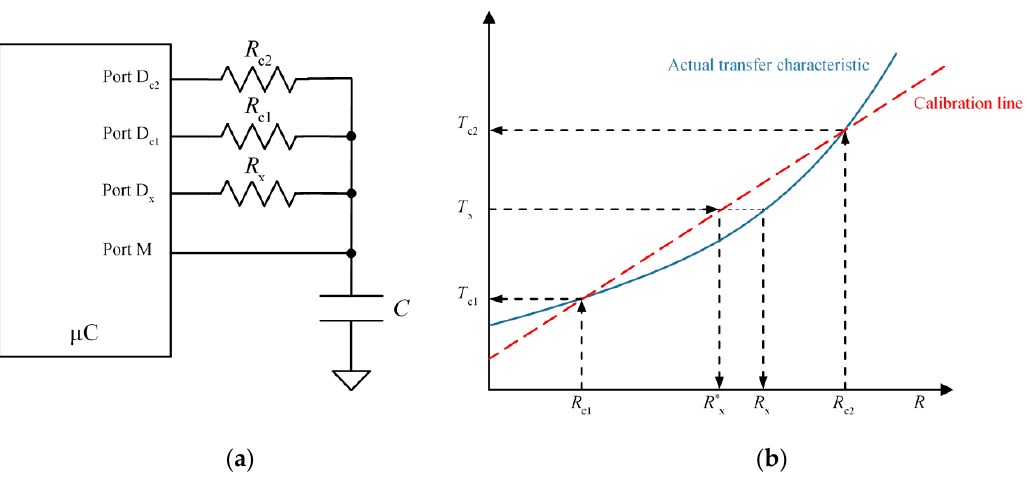
Figure 3. Two-point calibration technique: ( a ) circuit and ( b ) actual and calibration transfer characteristics.